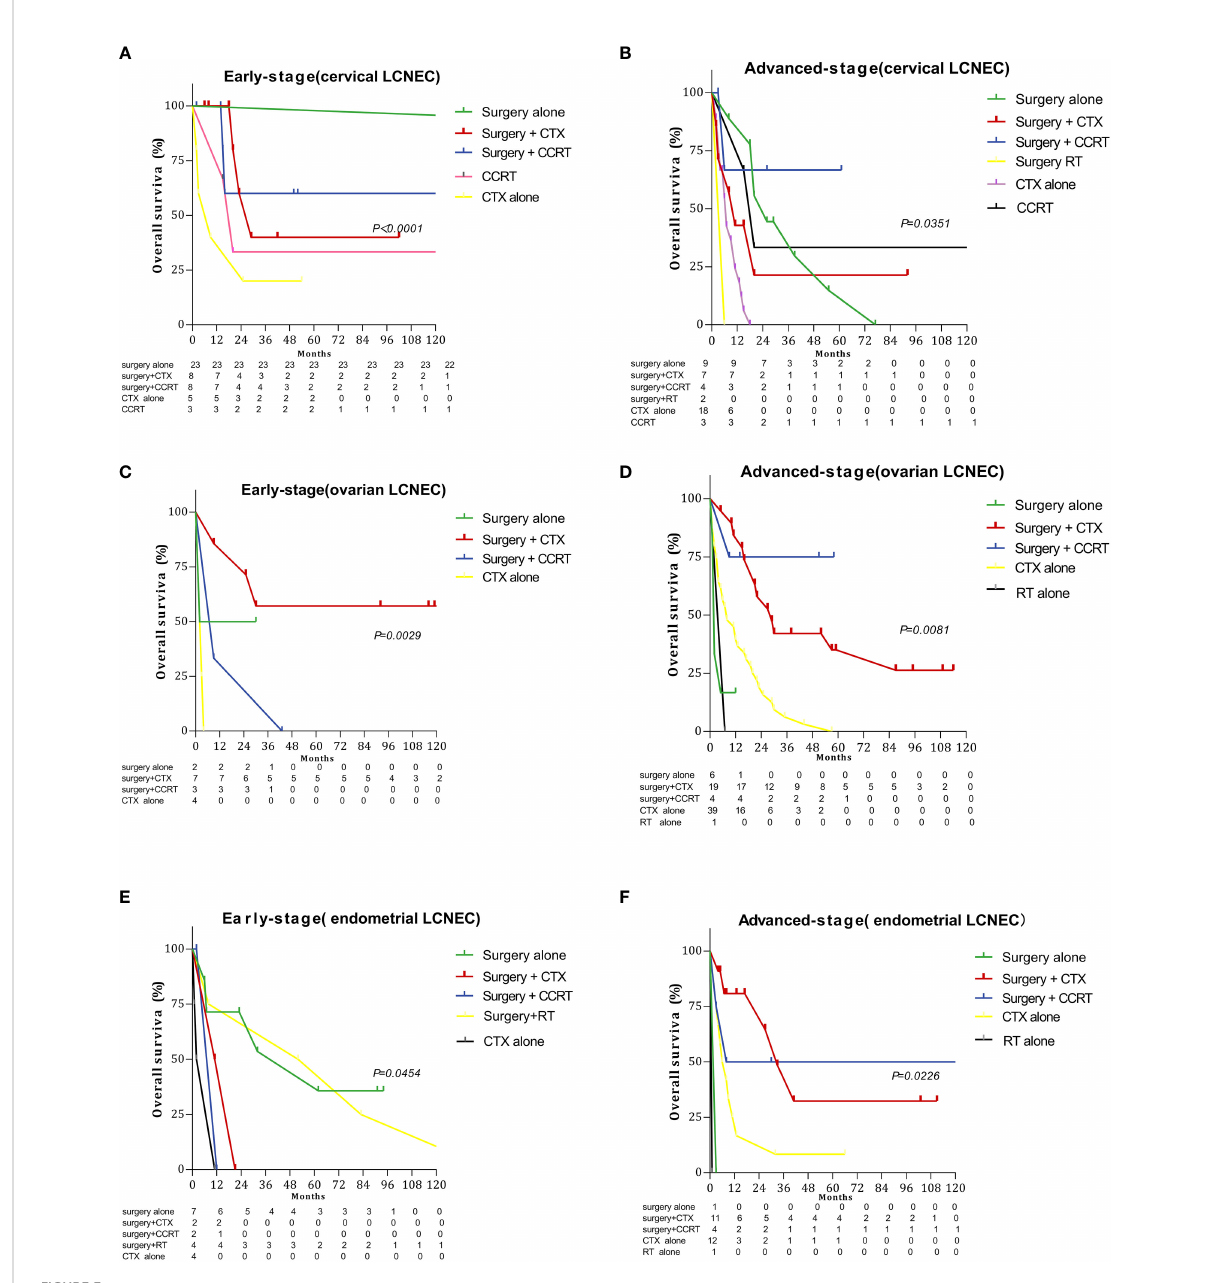
FIGURE 3 Survival curves for gynecologic LCNEC patients with early- and advanced-stage disease for different treatment regimens: (A) overall survival (OS) in the early stage with cervical LCNEC; (B) overall survival (OS) in the advanced stage with cervical LCNEC; (C) overall survival (OS) in the early stage with ovarian LCNEC; (D) overall survival (OS) in the advanced stage with ovarian LCNEC; (E) overall survival (OS) in the early stage with endometrial LCNEC; (F) overall survival (OS) in the advanced stage with endometrial